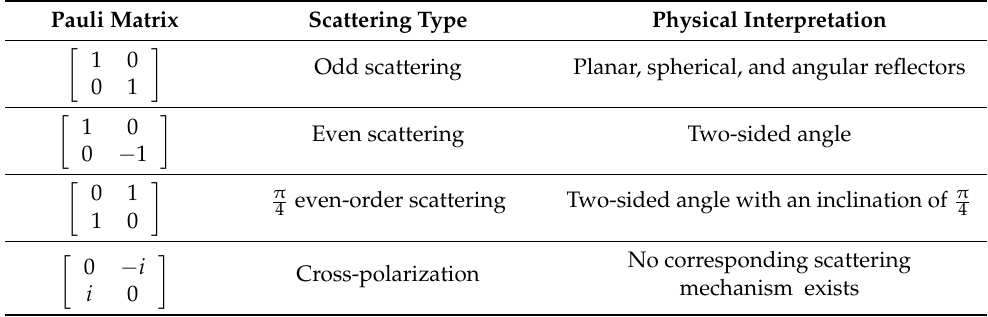
Table 3. Physical interpretation of the Pauli decomposition in the horizontal–vertical orthogonal basis. Pauli Matrix